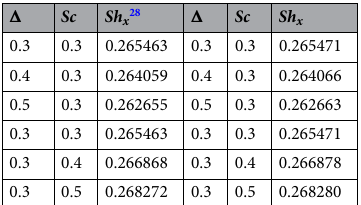
Table 3. Numerical outcomes for Sherwood number.